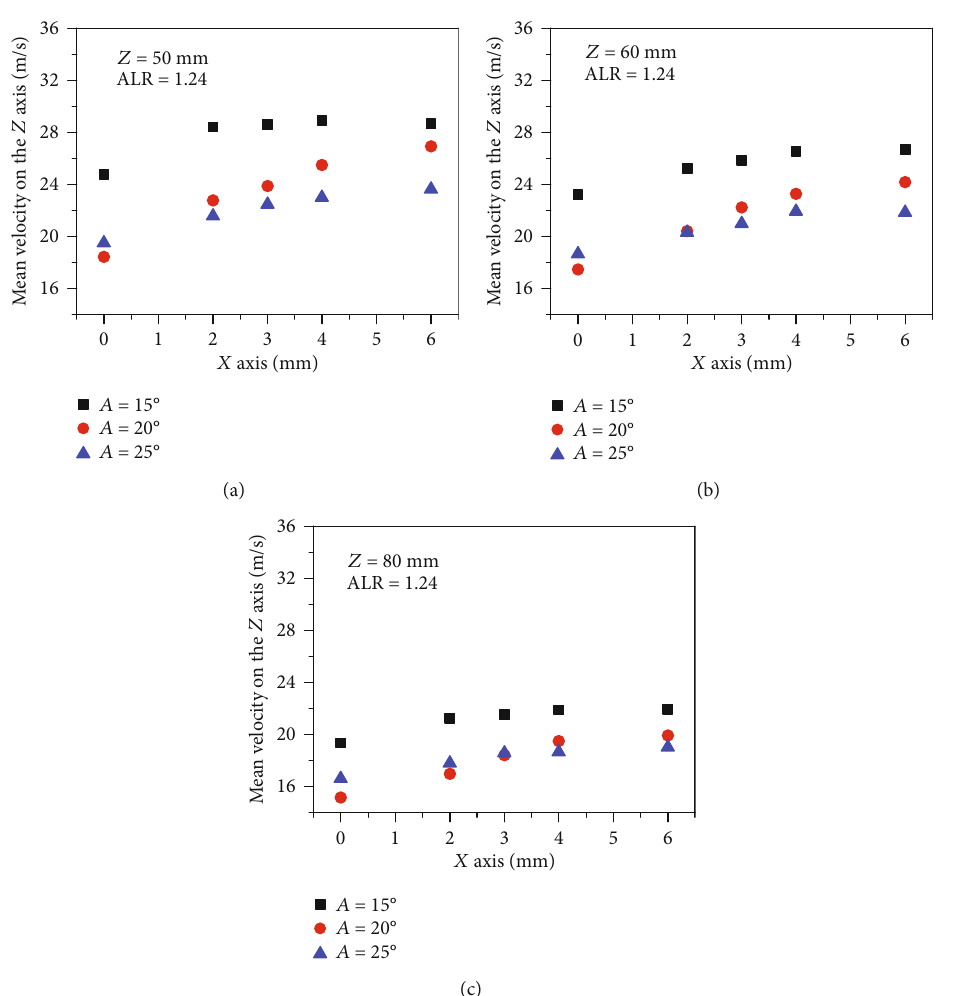
Figure 12: The droplet mean velocity on the Z axis of A series nozzle correlation at test position ( ALR = 1 : 24